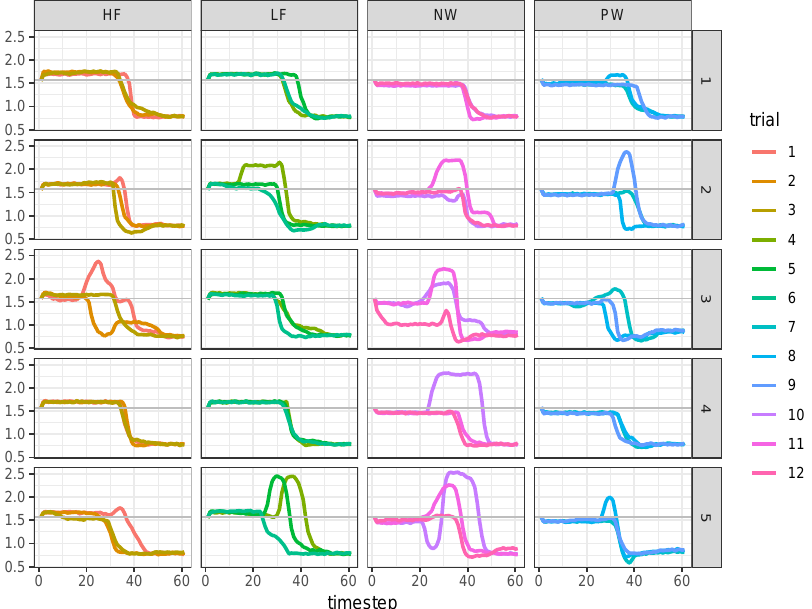
Figure 3. language dataset: Mouse-tracking trajectories Y plotted over the time step n = 1, . . . , N . Note that the categorical levels are represented column-wise, subjects are represented row-wise, whereas distractor (D) and target (T) sections are represented above and below the solid gray